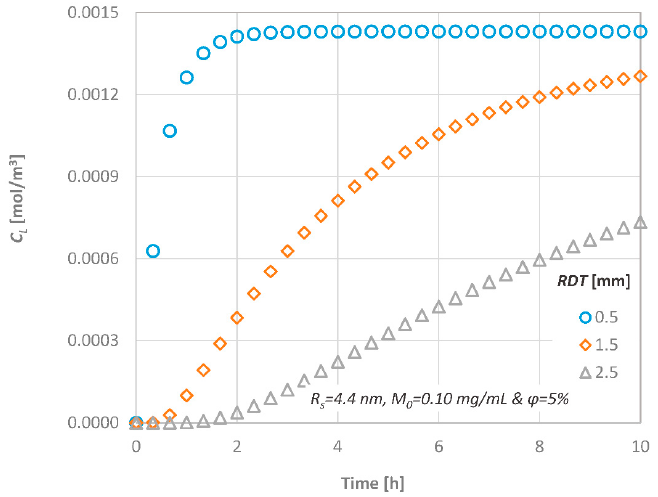
Figure 7. Effect of the Remaining Dentin Thickness ( RDT ) on the diffusion characteristics; C L versus time.